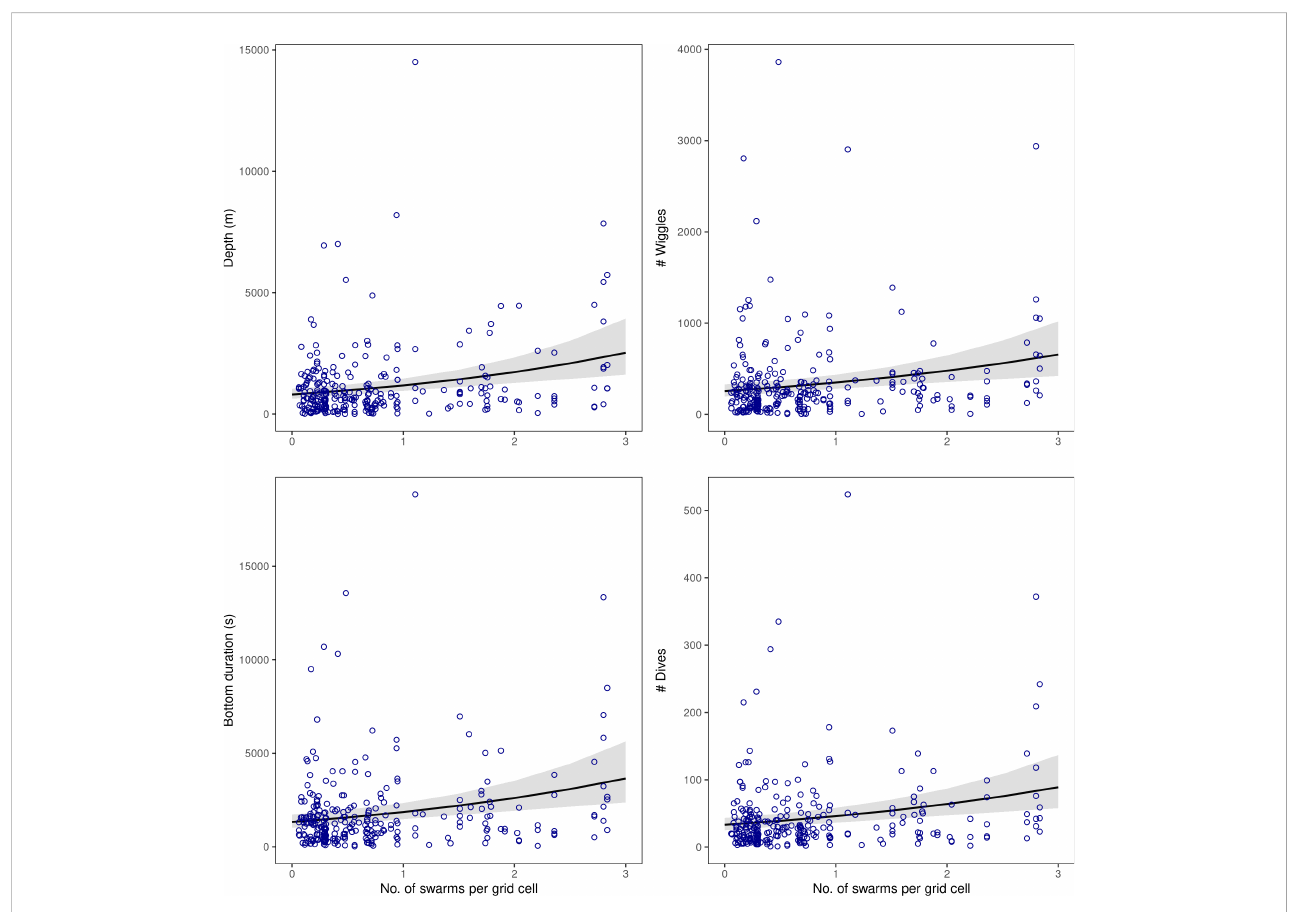
FIGURE 4 Results from the generalised linear mixed effects models showing the diving responses [summed depth, bottom duration, number of wiggles, and number of dives over each spatial grid; y-axes] modelled in relation to krill swarm number within spatial grid cells across the acoustic survey domain. Diving parameters showed no association with krill swarm biomass; full model results are given in Table